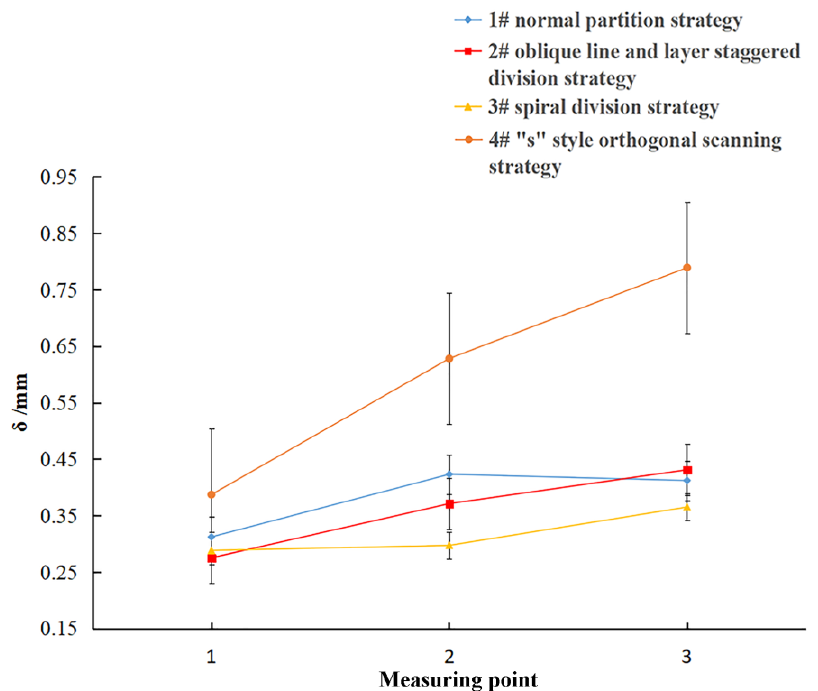
Figure 14 . Relationship between the deformation and scanning line lengths under different scanning strategies.